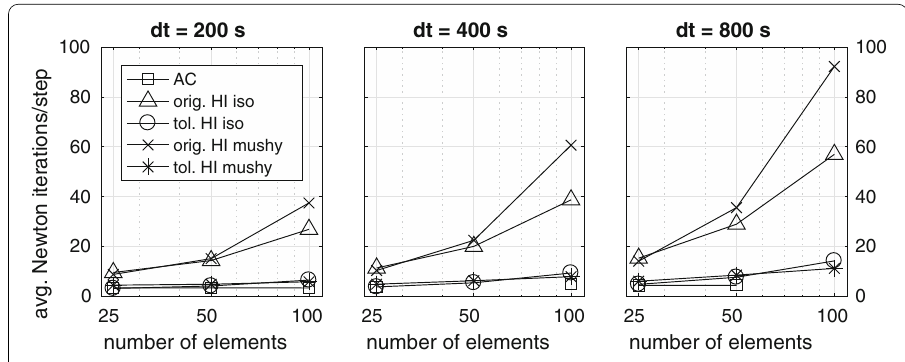
Fig. 8 Melting front example: average number of iterations of different methods for latent heat depending on spatial and temporal discretization. Missing data points for the AC scheme indicate that no convergence was achieved for these parameter choices